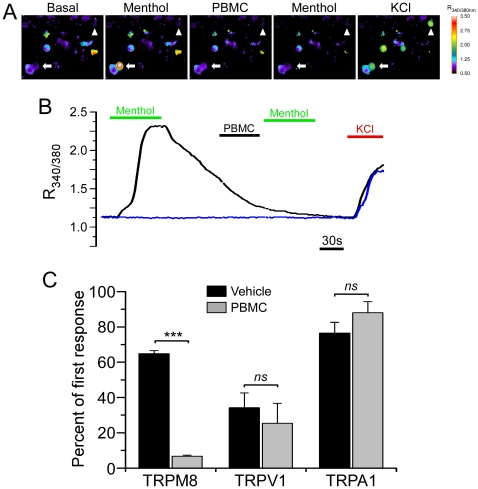
PBMC shows selectivity for TRPM8.
A) Representative pseudocolor images (n = 4) of the Fura-2 ratio in cultured TG neurons. In this field a single cell is robustly activated by 200 µM menthol (arrow), but after treatment with PBMC (50 nM) a subsequent menthol application was ineffective. B) Ratio values of the cells shown in A (black trace: arrow; blue trace: arrowhead). Note that PBMC alone did not alter intracellular Ca2+ in menthol-insensitive, K+-sensitive neurons (arrowhead). C) Average peak ratio values of the second menthol response presented as a percentage of the first response compared for vehicle- (black bars; 65.0±2.0) and PBMC- (grey bars; 7.0±1.0) treated cells. 25 nM PBMC significantly inhibited menthol responses in HEK293T cells transfected with TRPM8 as compared with vehicle controls (Student's t-test, ***p<0.001). However, the drug did not affect capsaicin responses in TRPV1-transfected cells or AITC responses in TRPA1-transfected cells (Student's t-test, n.s. p>0.05).